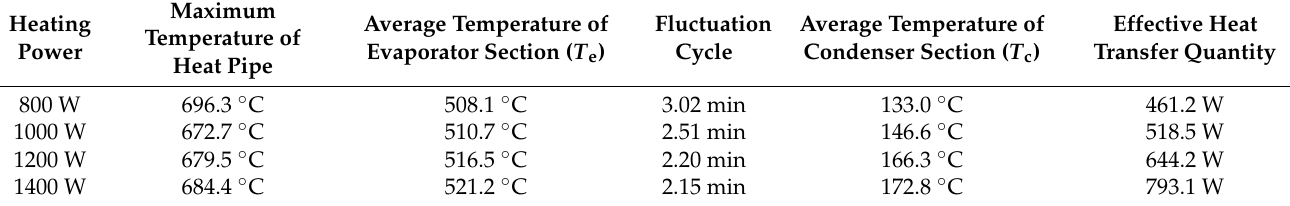
Table 3. Operating parameters of Na-K heat pipe under different heating